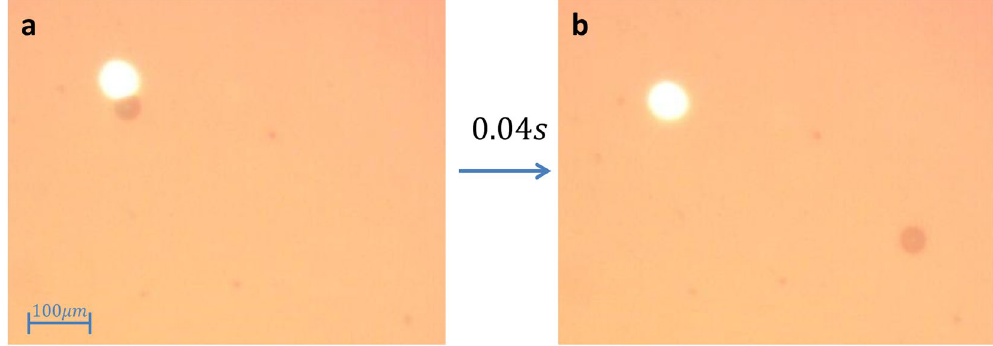
Figure 1. Light induced abrupt micro-sphere translation. Panel (a) shows the 42 μ m diameter spherical particle and the 405 nm laser beam as the respective dark and bright patches. Panel (b) shows that 40 milliseconds later the microsphere has traversed a distance roughly 10 times its